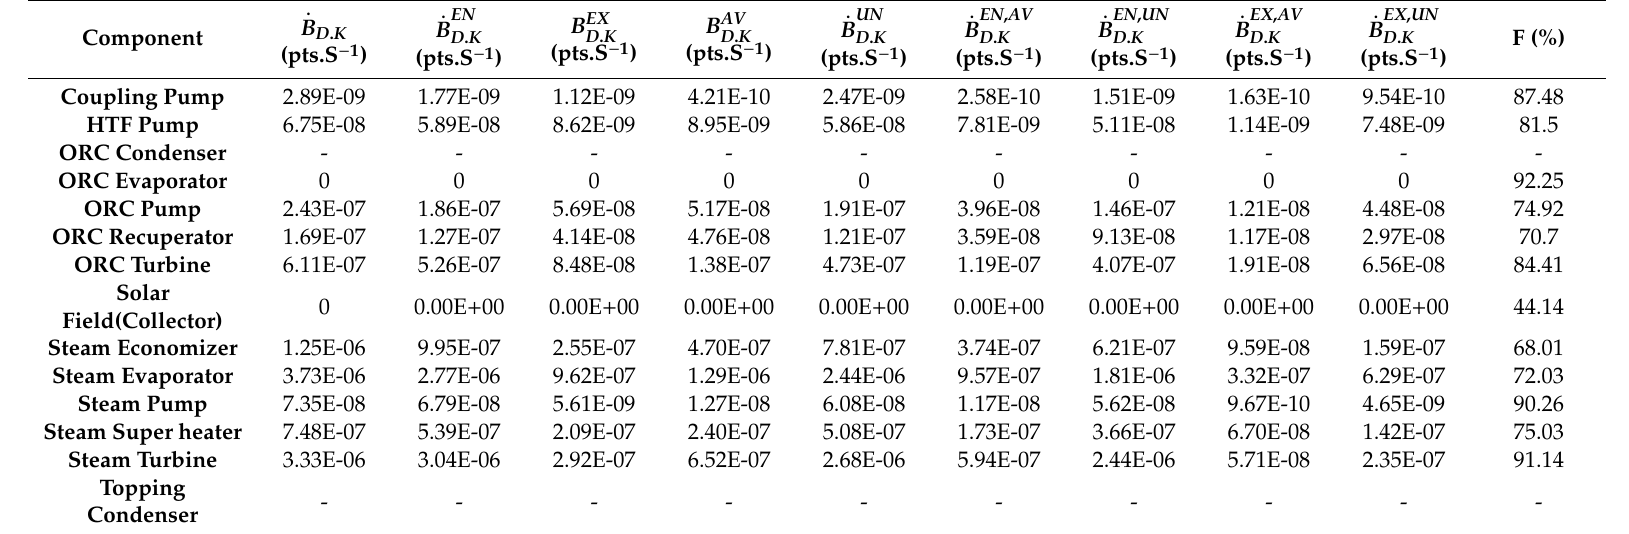
Table 18. Advanced exergo-environmental analysis in the solar–geothermal cycle